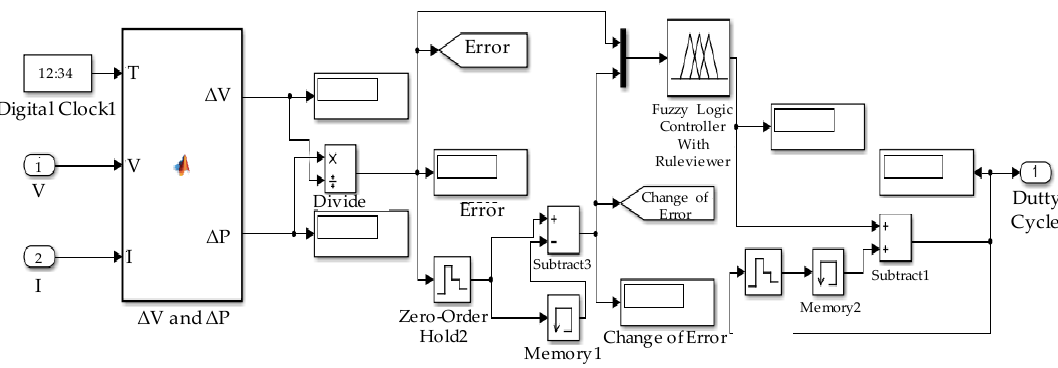
Figure 10. Fuzzy logic controller.